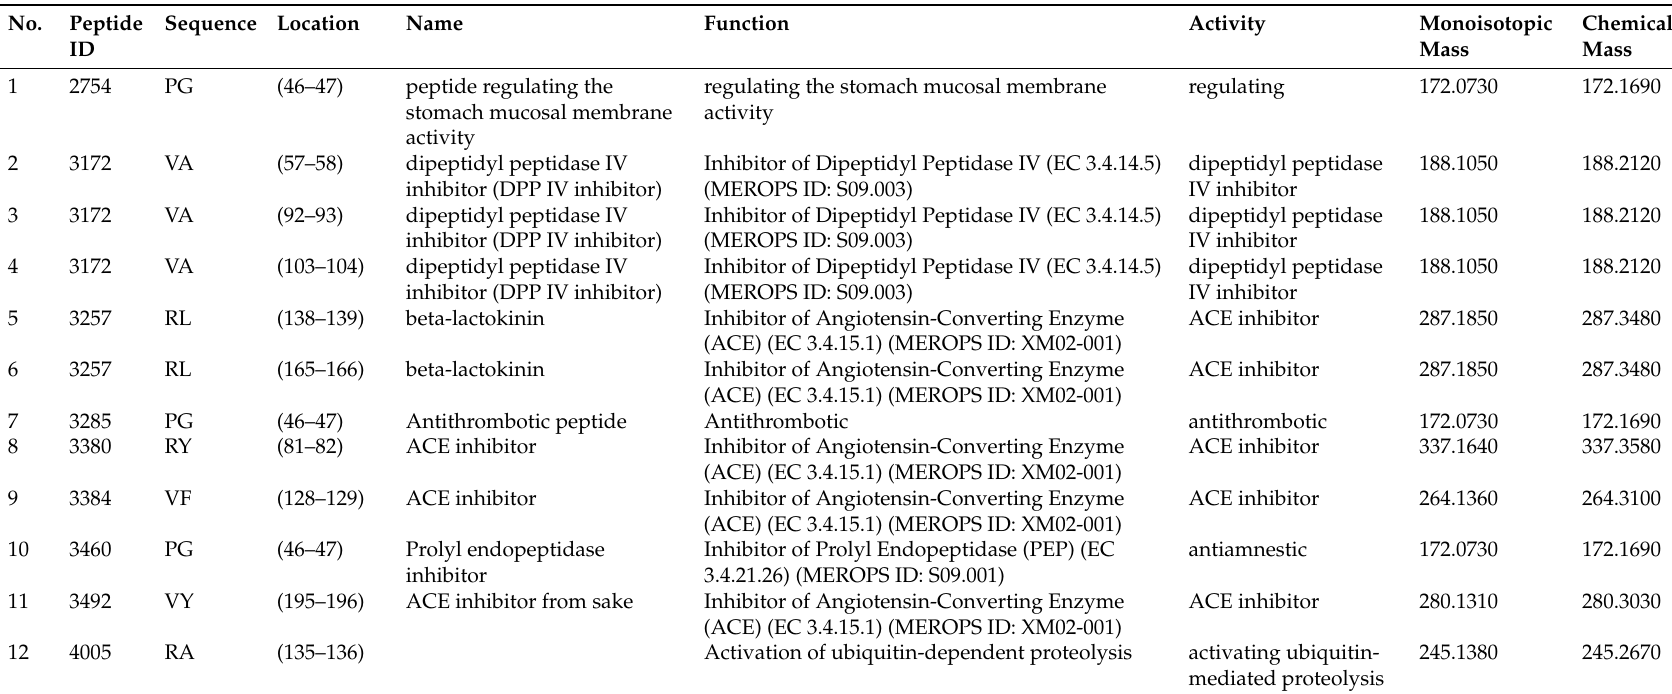
Table A49. Bioactive peptides from RubisCO of Halophila stipulacea . In silico enzymatic cleavage was carried out by using pepsin (pH >